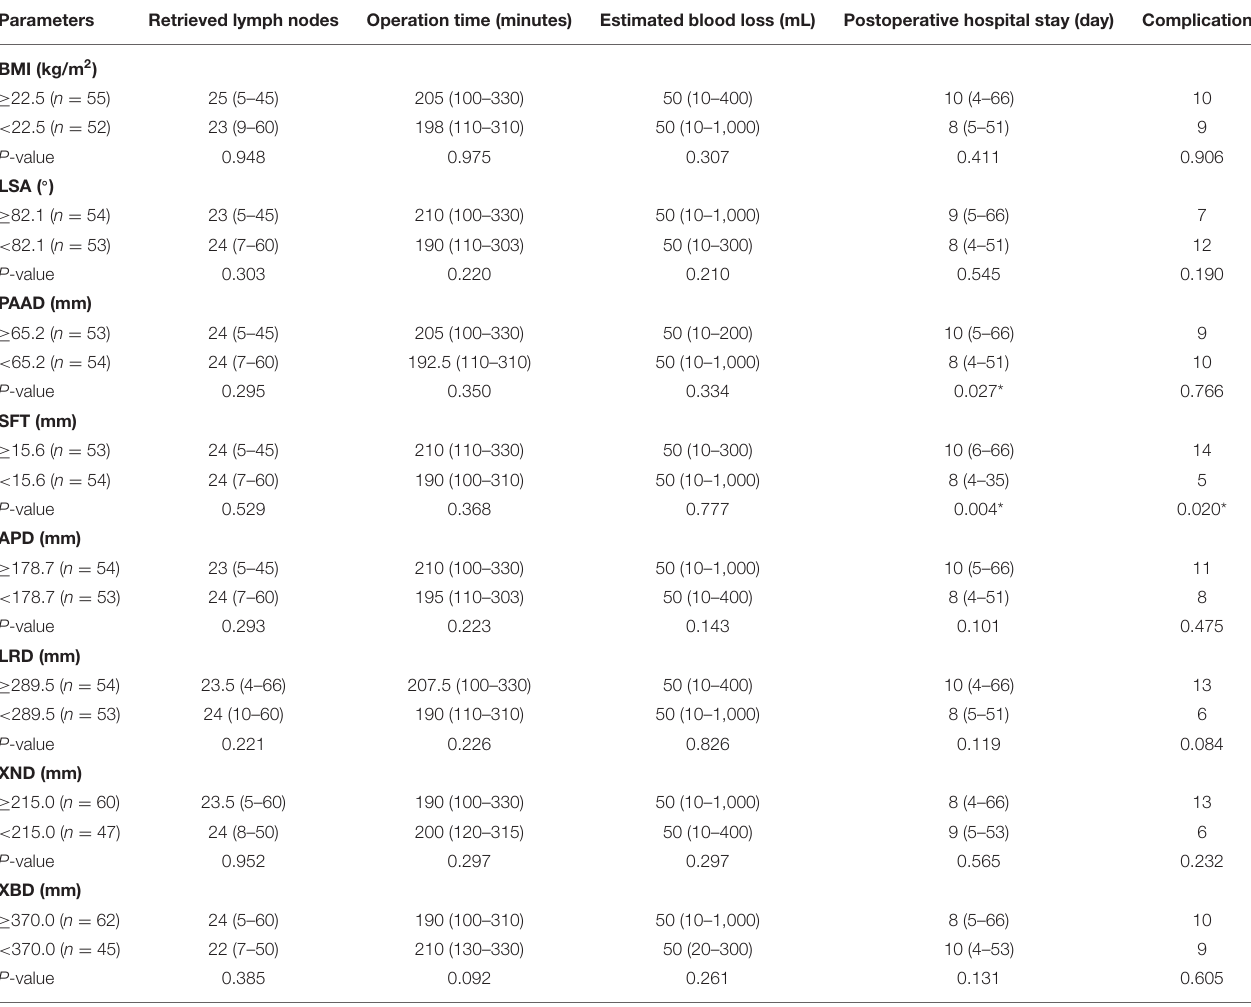
TABLE 4 | Short-term surgical outcomes in female patients ( n = 107).